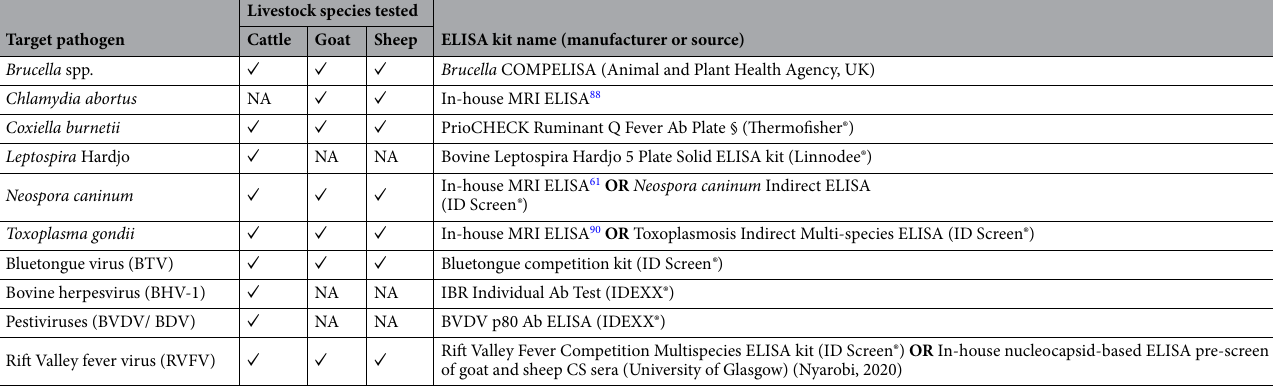
C. burnetii, and RVFV using commercial ELISA, as per manufacturer’s instructions (Table 3). Cattle sera were additionally tested for exposure to Leptospira Hardjo serovars, BHV-1, and BVDV (Table 3). Absorbance was